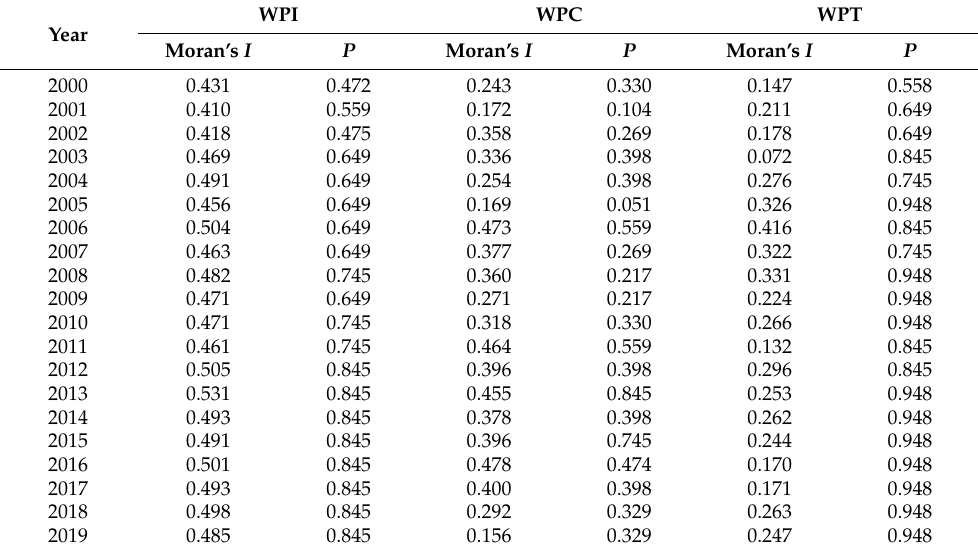
Table 3. The Global Moran’s I coefficient of water productivity in the Yellow River Basin from 2000 to 2019.